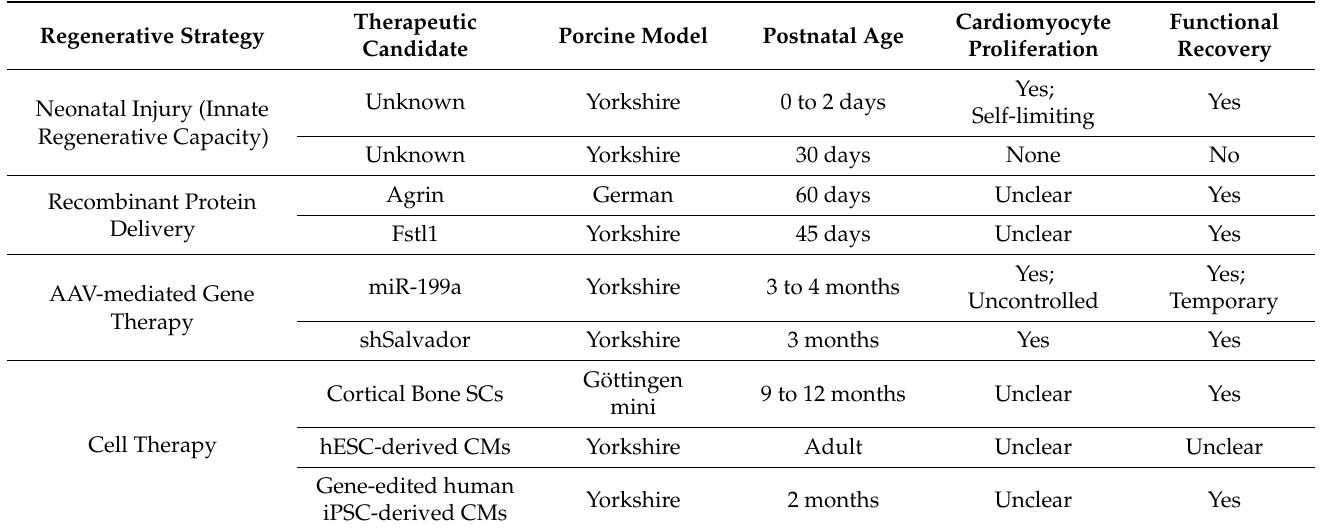
Table 1. Summary of porcine developmental and therapeutic heart regeneration studies (References in